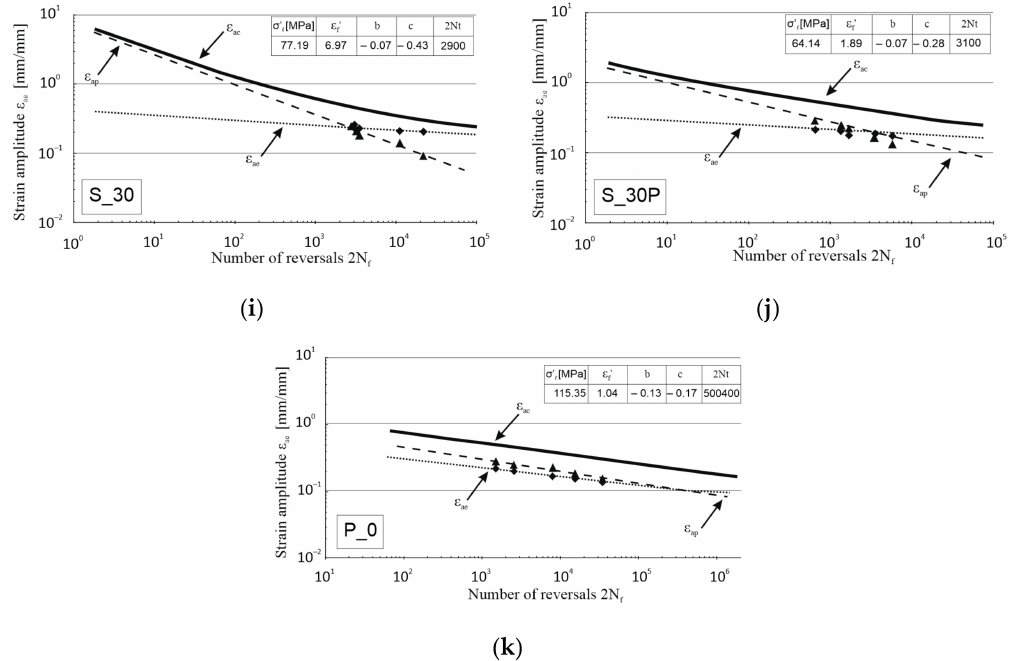
Figure 8. Number of half-cycle reversals vs. strain amplitude in log–log coordinates for as-built samples, heat-treated and conventionally made material (( a )—S_01, ( b )—S_01H, ( c )—S_01HP, ( d )—S_01P, ( e )—S_17, ( f )—S_17H, ( g )—S_17HP, ( h )—S_17P, ( i )—S_30, ( j )—S_30P, ( k